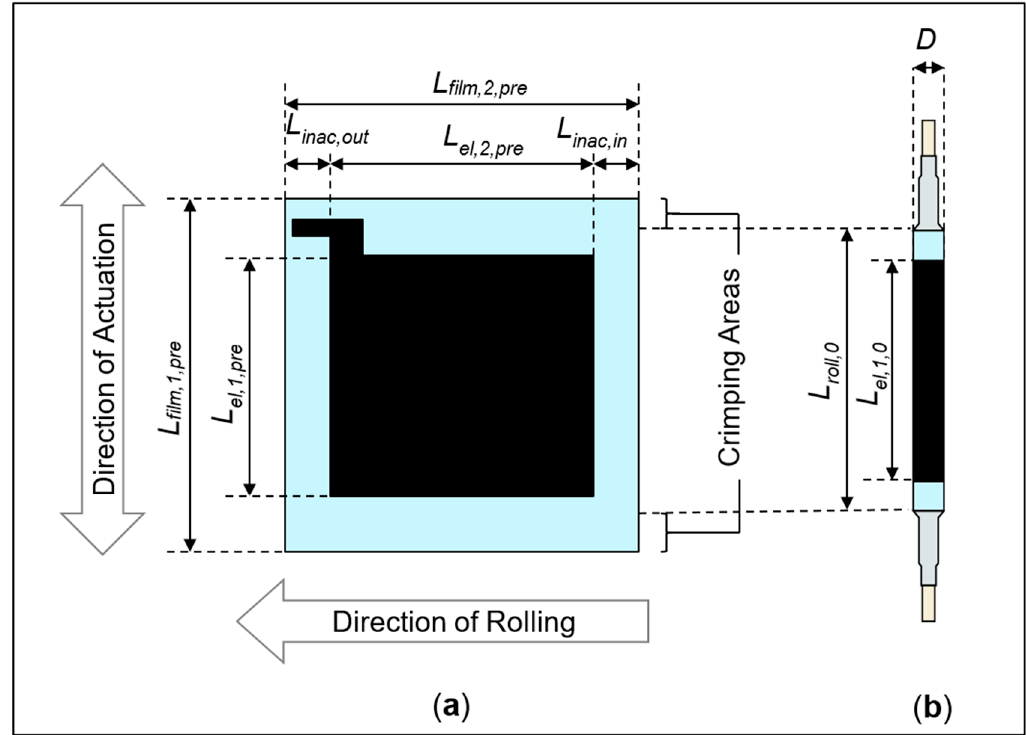
Figure 9. Relevant dimensional parameters of the RDEAs. Schematic of the Figure 5 right after the screen ‐ printing ( a ), and relaxed state after rolling ( b ).